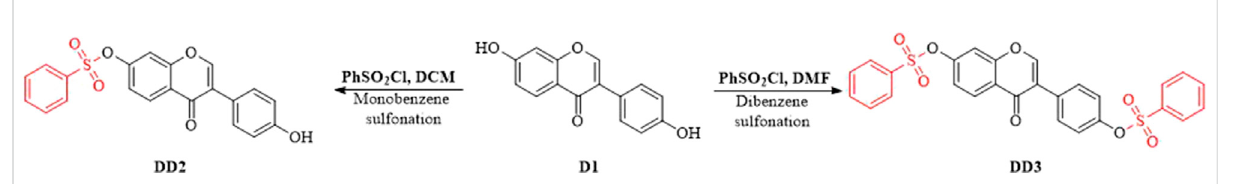
FIGURE 1 Synthesis of D1 benzene sulfonate